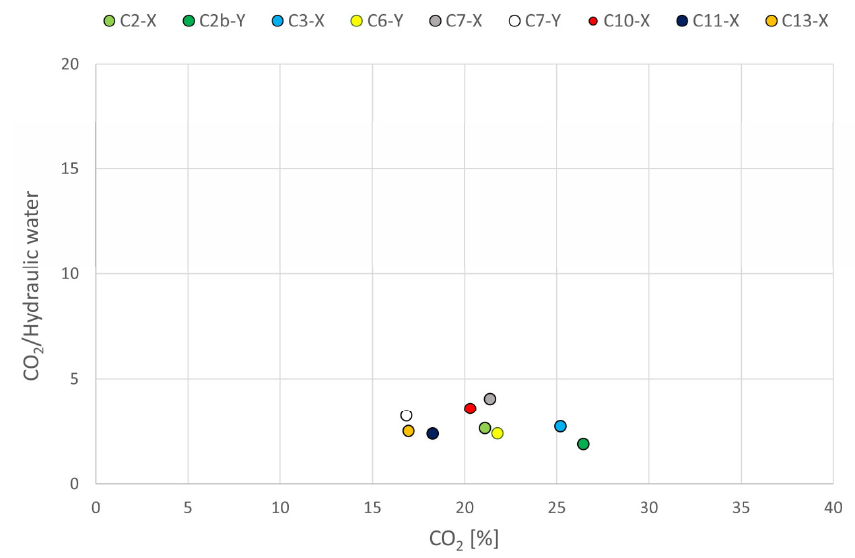
Figure 6. Diagram of CO 2 /H 2 O vs. CO 2 measured on the enriched binders.